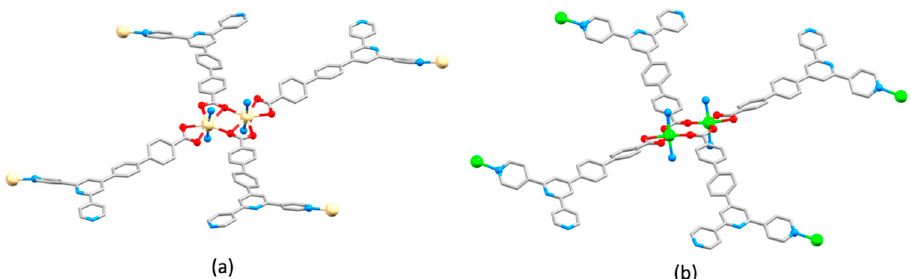
Figure 34. (a) The {Cd 2 (O 2 C) 4 } node showing four of the eight coordinated ligands in [Cd( 33 ) 2 ] n . n DMF . 2 n H 2 O (CSD refcode BOBRIW), compared with (b) the corresponding unit in [Zn( 33 ) 2 ] n (refcode TEZJOA).